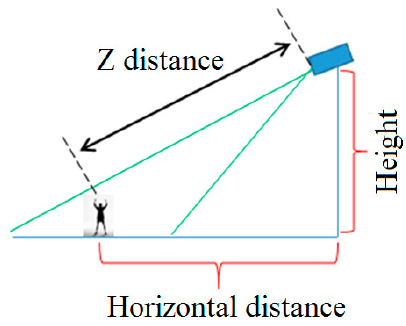
Figure 12. Example of camera setup. Table 3. Camera setup used to collect the 11 datasets (unit: meters).